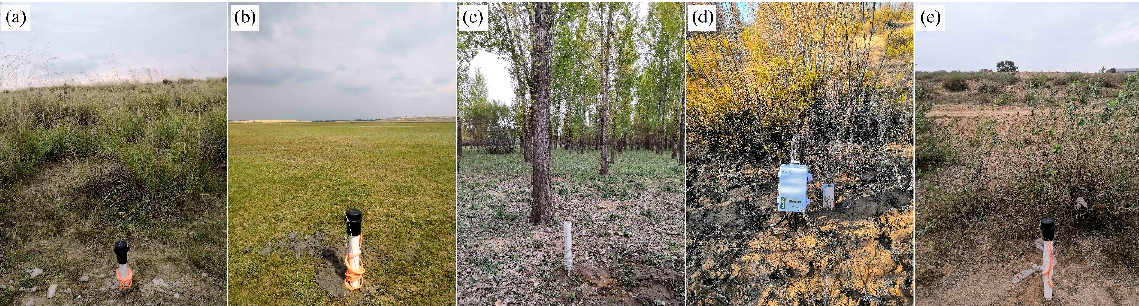
Figure 2. The dominate vegetations, i.e., ( a ) Achnatherum splendens , ( b ) Carex stenophylla , ( c ) Populus alba , ( d ) Salix psammophila and ( e ) Caragana korshinskii , in the study site.